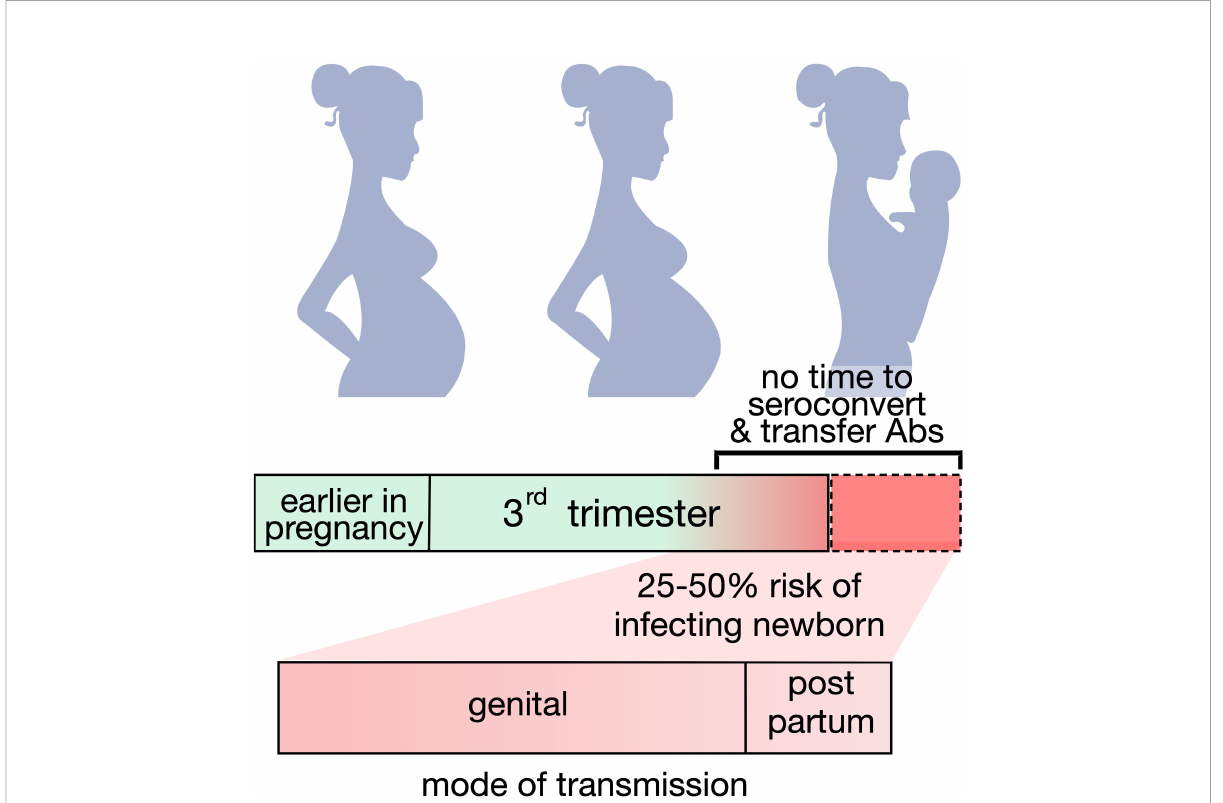
FIGURE 1 Maternal seroconversion and nHSV infection risk. Graphic representing the potential risk of transmitting neonatal HSV when seroconversion is not achieved or achieved too close to delivery. The majority of infants acquire disease from infected mothers during